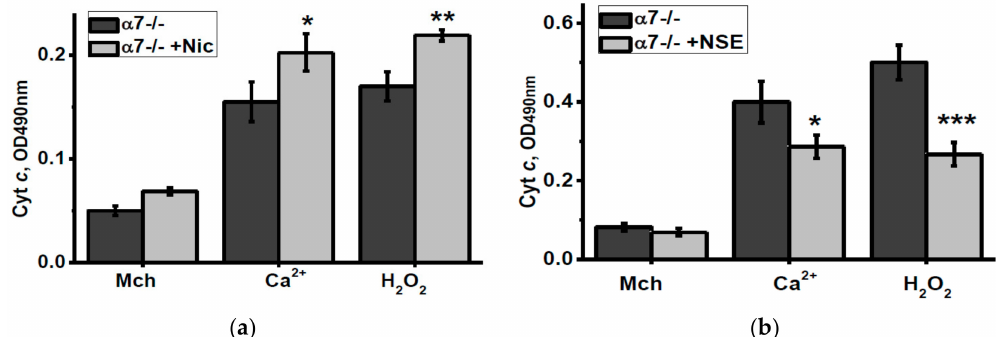
Figure 5. Level of cytochrome c (Cyt c) released from the brain mitochondria of α 7- / - mice treated by either nicotine ( a ) or NSE ( b ) under the e ff ect of 0.9 µ M Ca 2 + or 0.5 mM H 2 O 2 . Each column corresponds to M ± SD, n-5. * p < 0.05; ** p < 0.005; *** p < 0.0005 compared to non-treated α 7- / - mice. Mch—cyt c released from non-treated